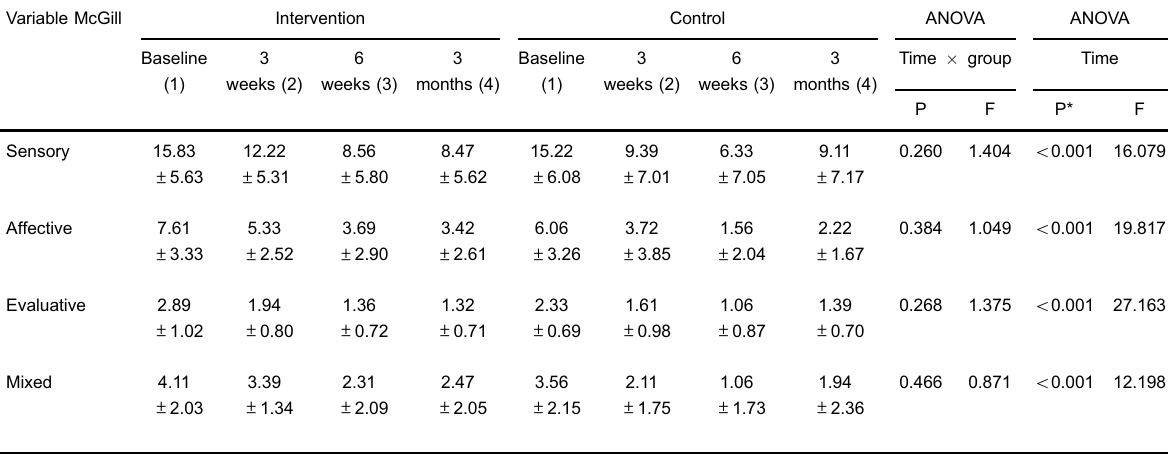
Table 2. Mean values for the sensory, affective, evaluative, and mixed aspects of pain at baseline, 3 weeks, 6 weeks, and 3 months for the two groups. Variable McGill